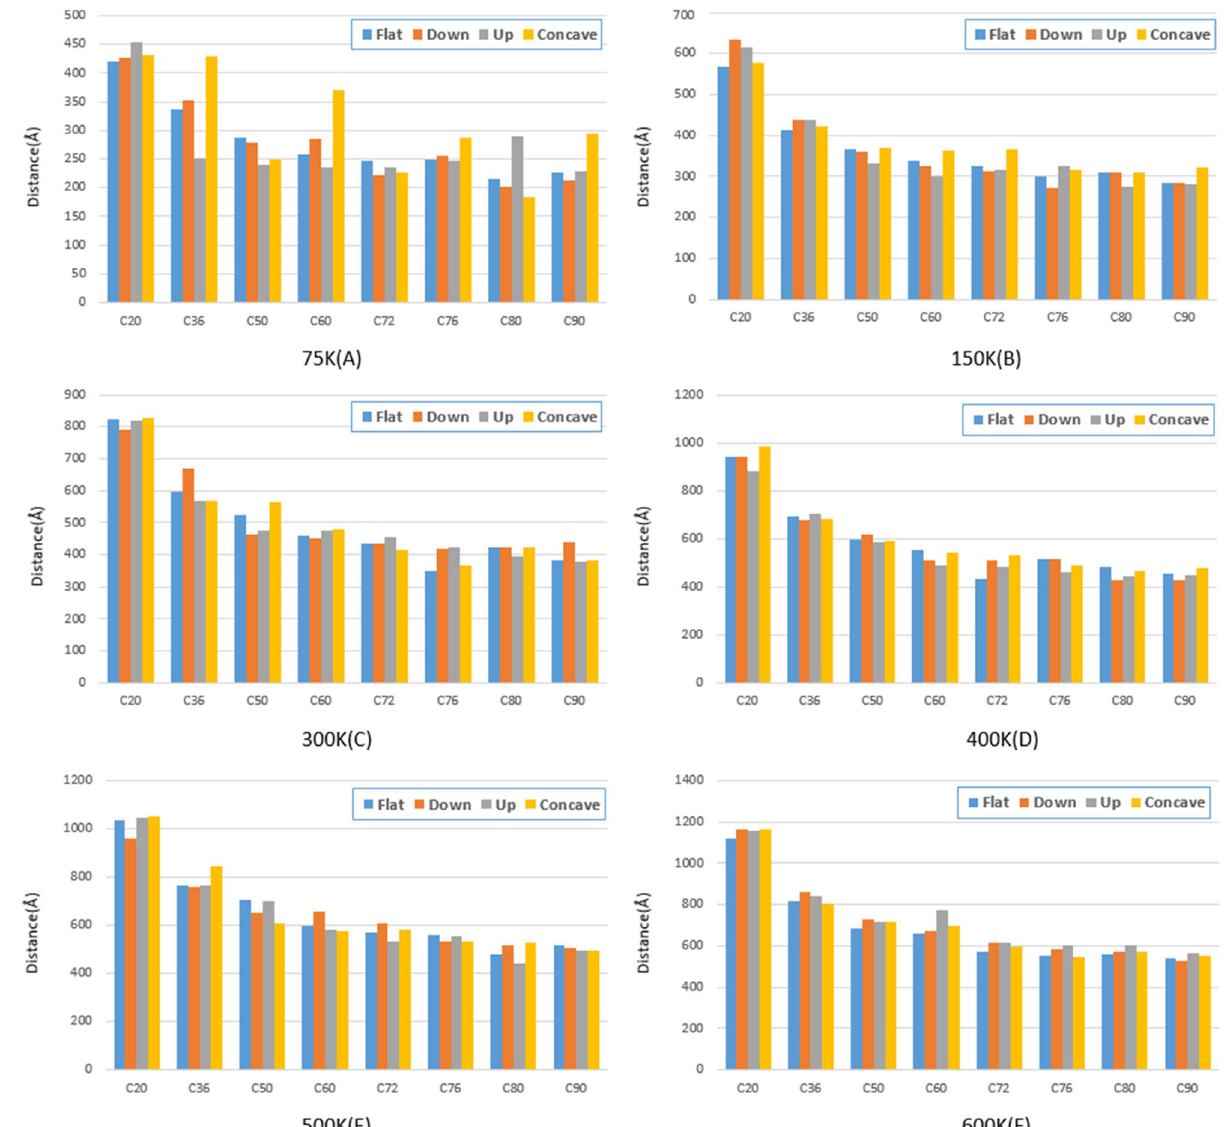
Figure 9. Traveled distance by fullerenes on a gold substrate for 75K ( A ), 150K ( B ), 300K ( C ), 400K ( D ), 500K ( E ), and 600K ( F ). The blue, red, black and yellow bars show the traveled distant of the molecules on the flat, down side of the step, top side of the step, and concave substrates,